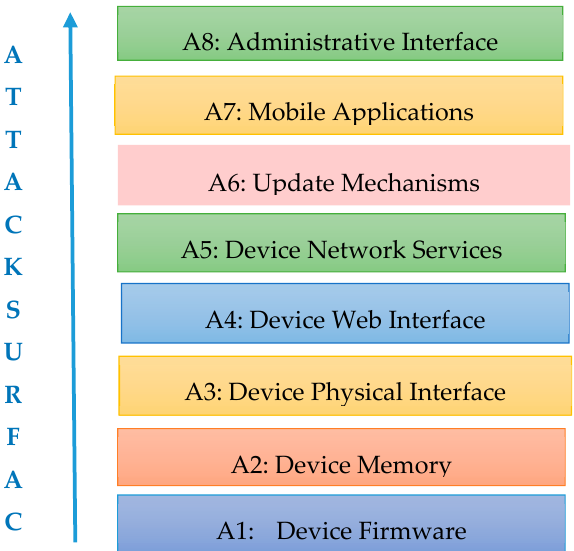
Figure 5. Attack Surfaces in an IoT System [33–35].